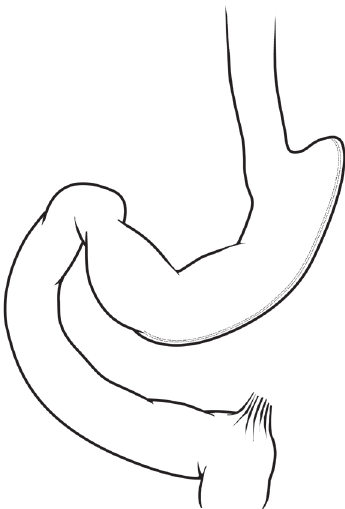
Figure 2. Vertical sleeve gastrectomy. A majority of the greater curvature is excised in this procedure, creating a tube-like stomach with a marked reduction in gastric